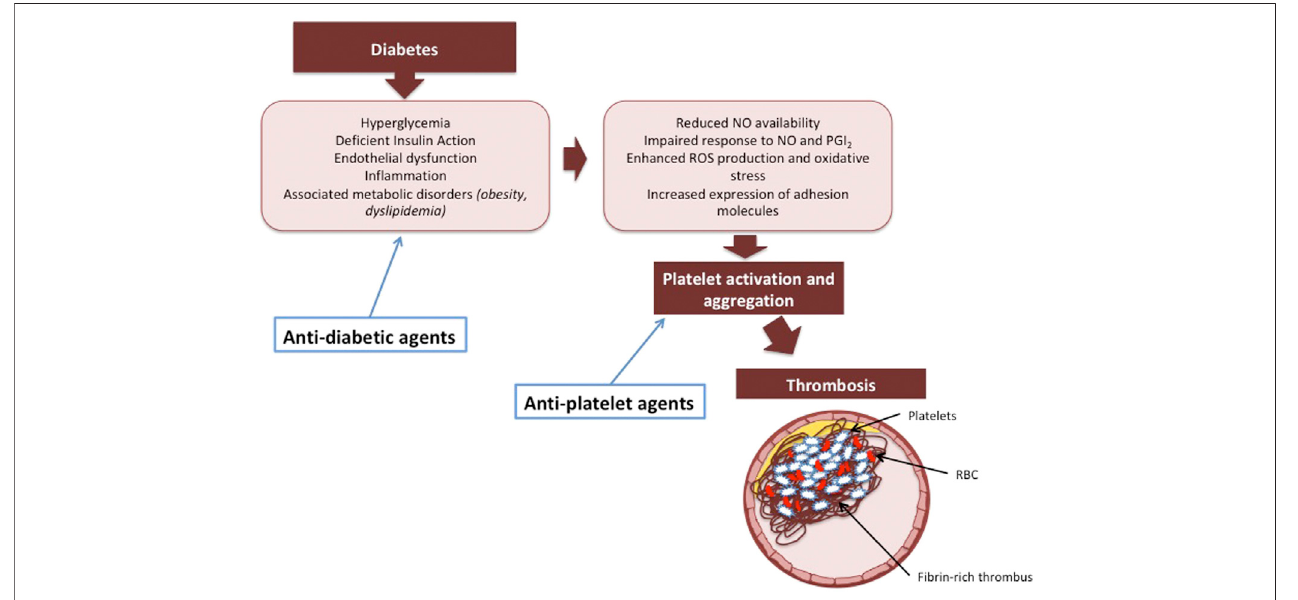
FIGURE 1 | The potential synergistic effect of anti-diabetic and anti-platelet agents on preventing thrombosis in diabetic patients.